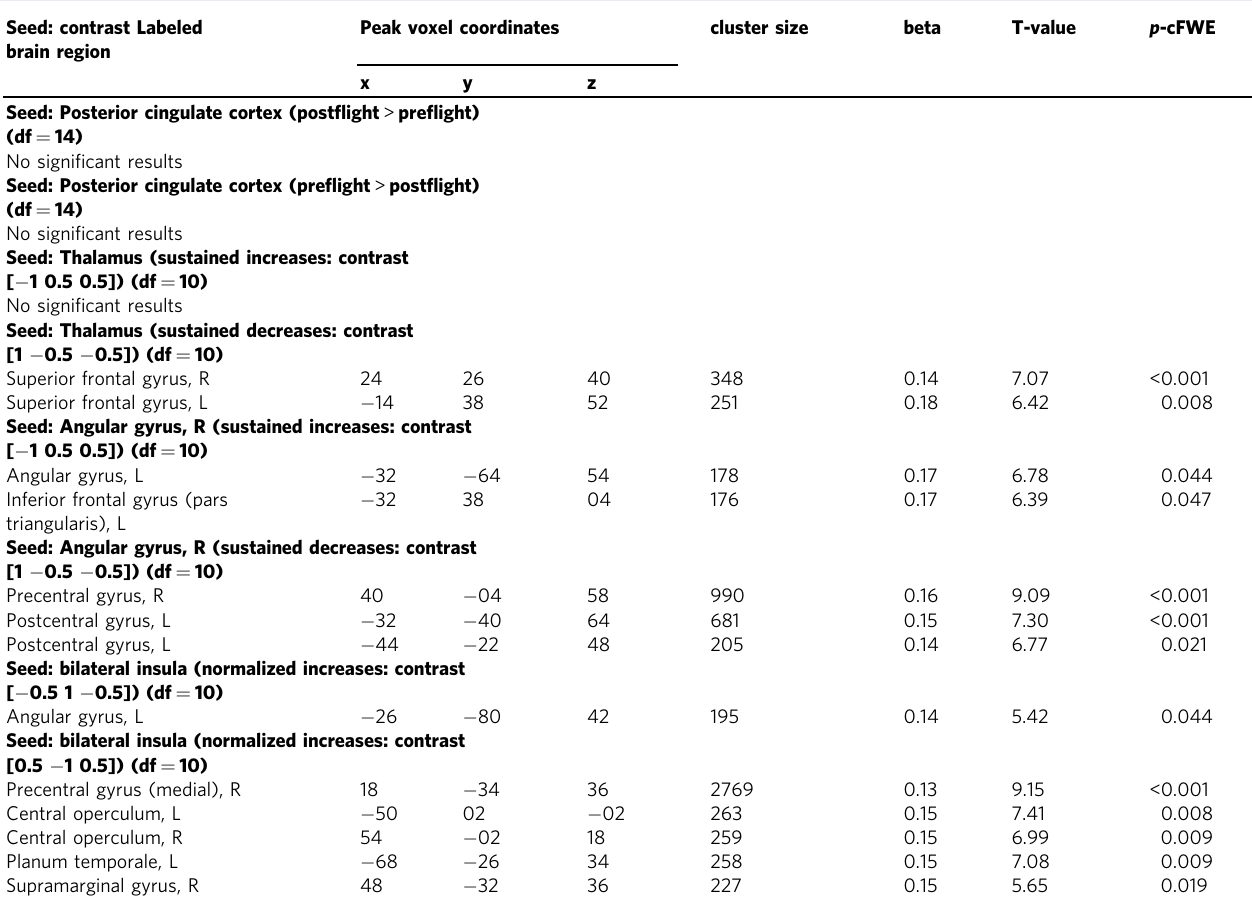
Table 2 Cluster information of seed-based connectivity analyses. Seed: contrast Labeled brain